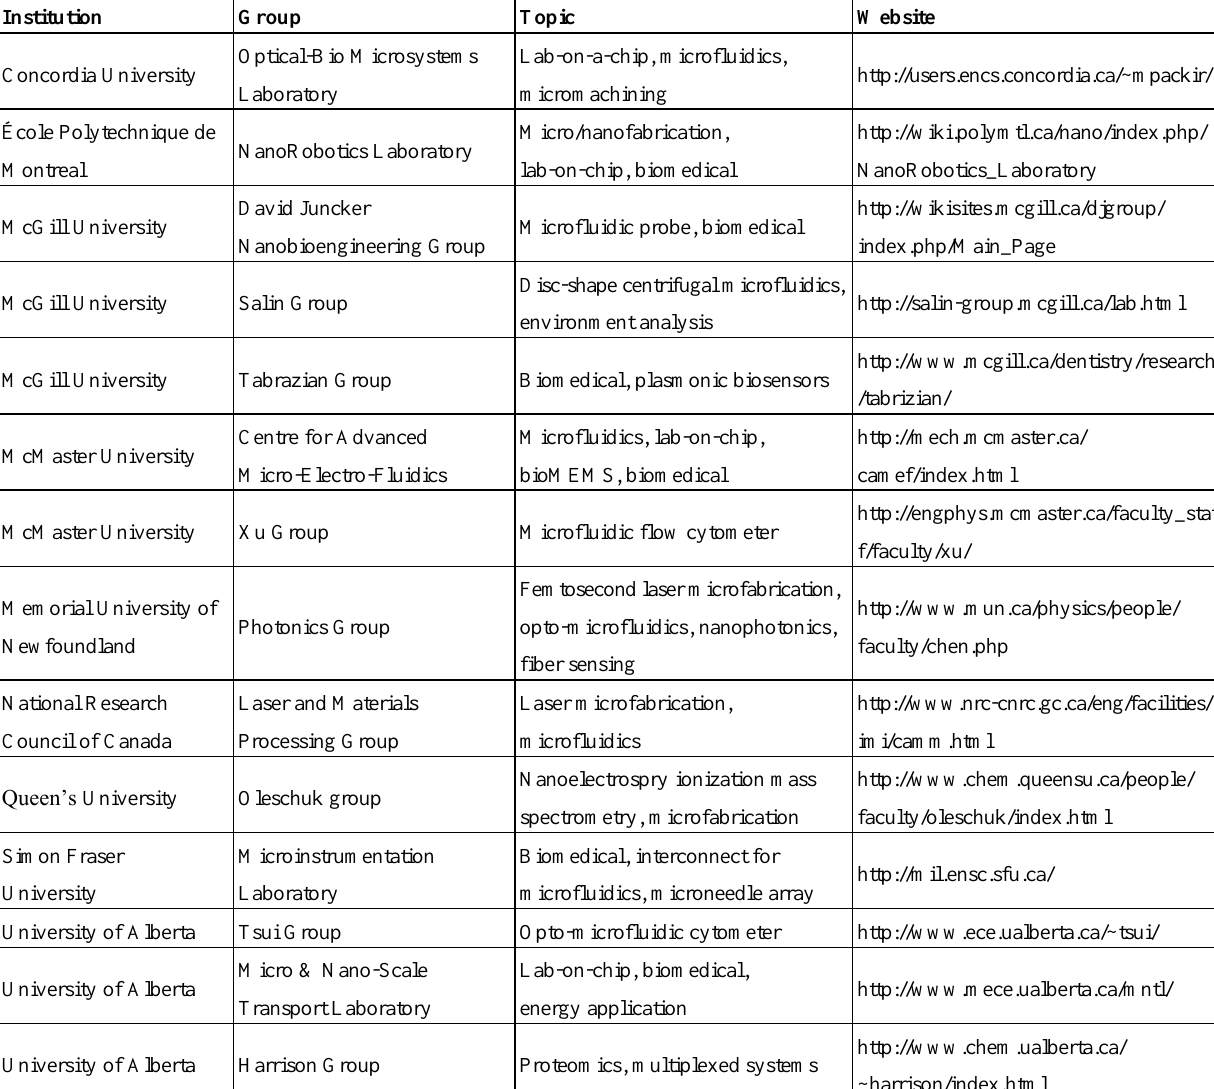
Table 1. List of some Canadian research institutions working on microfluidics and